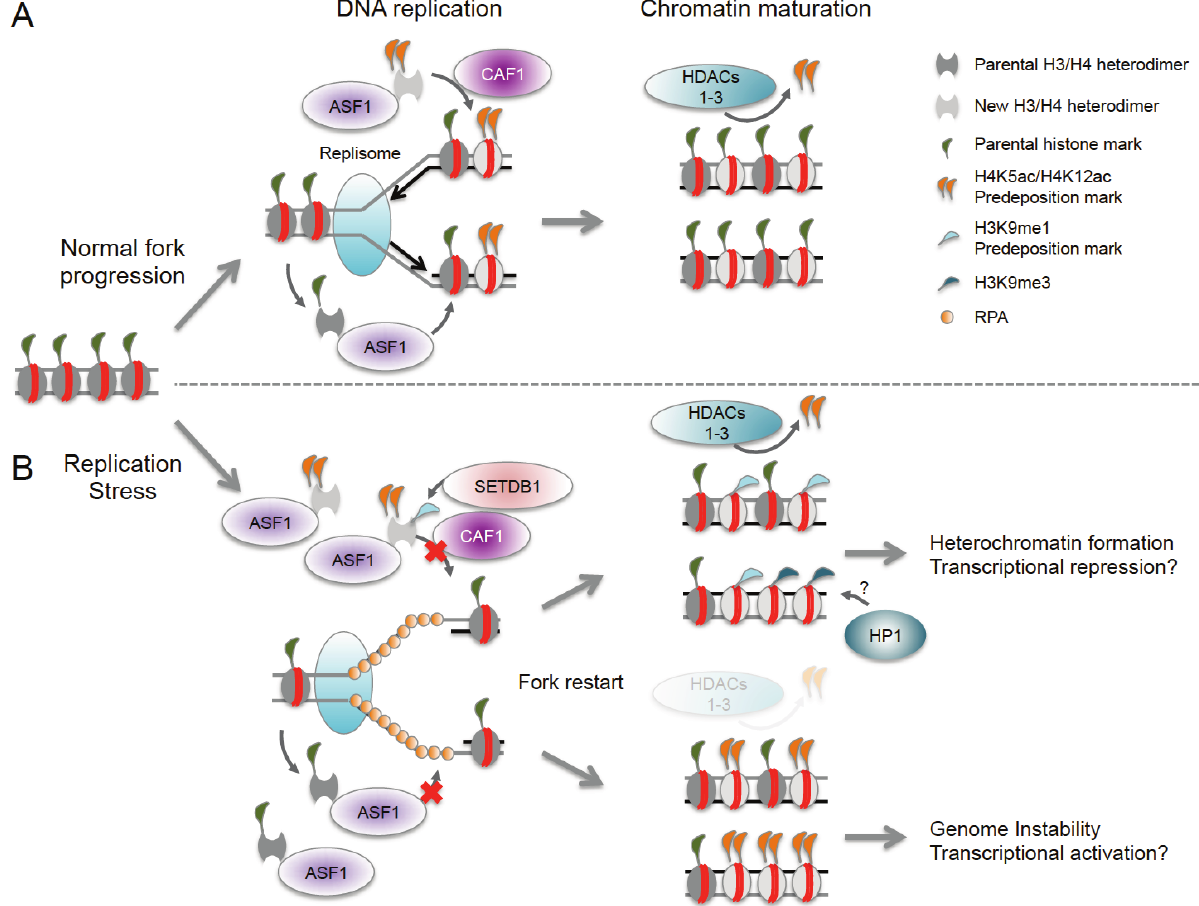
Figure 2. Epigenetic consequences of nucleosome reassembly defects at stalled